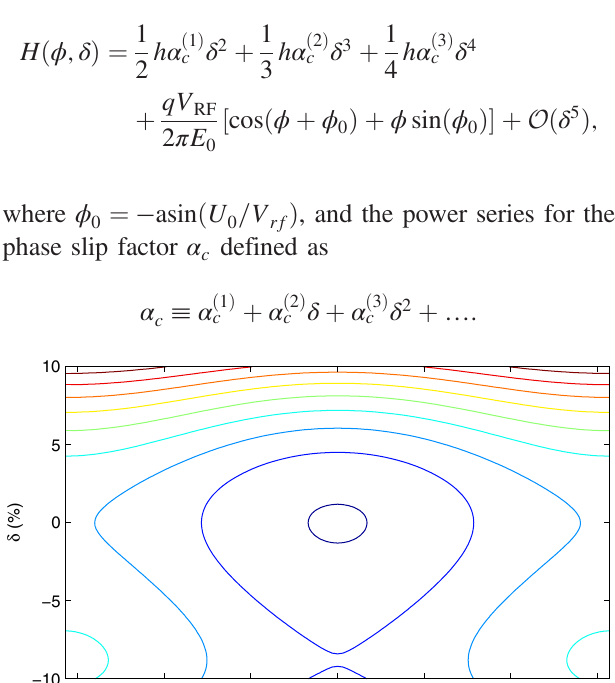
FIG. 4. Beam lifetime vs rf voltage for Diamond measured in single bunch for 0.15% coupling corrected with LOCO.